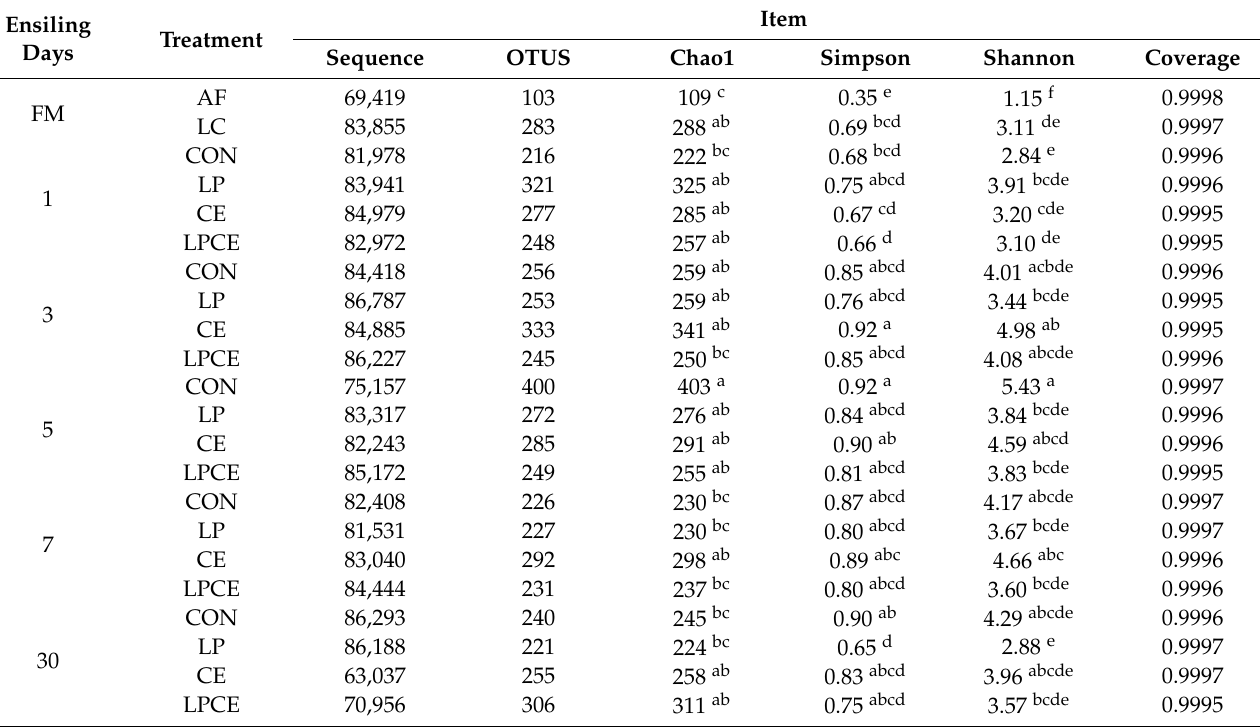
Table 4. Effect of additives and ensiling days on bacterial alpha diversity of fresh materials and mixed